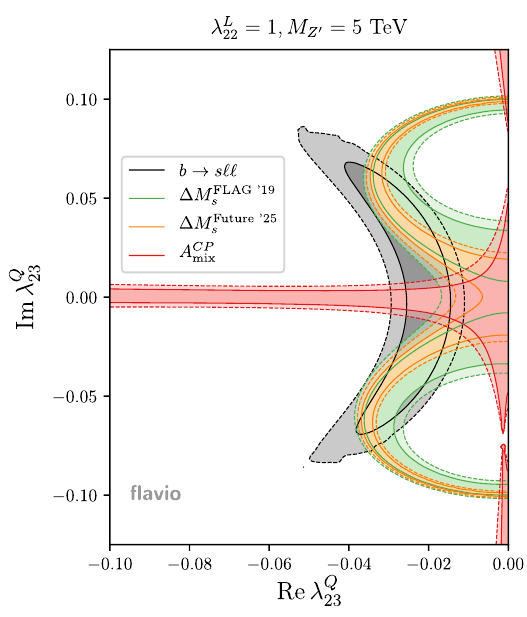
Figure 6 . Allowed regions at 1 (cid:27) (solid) and 2 (cid:27) (dashed) for b ! s‘‘ (grey), (cid:1) M (FLAG ’19) and orange (Future ’25)), and A CP